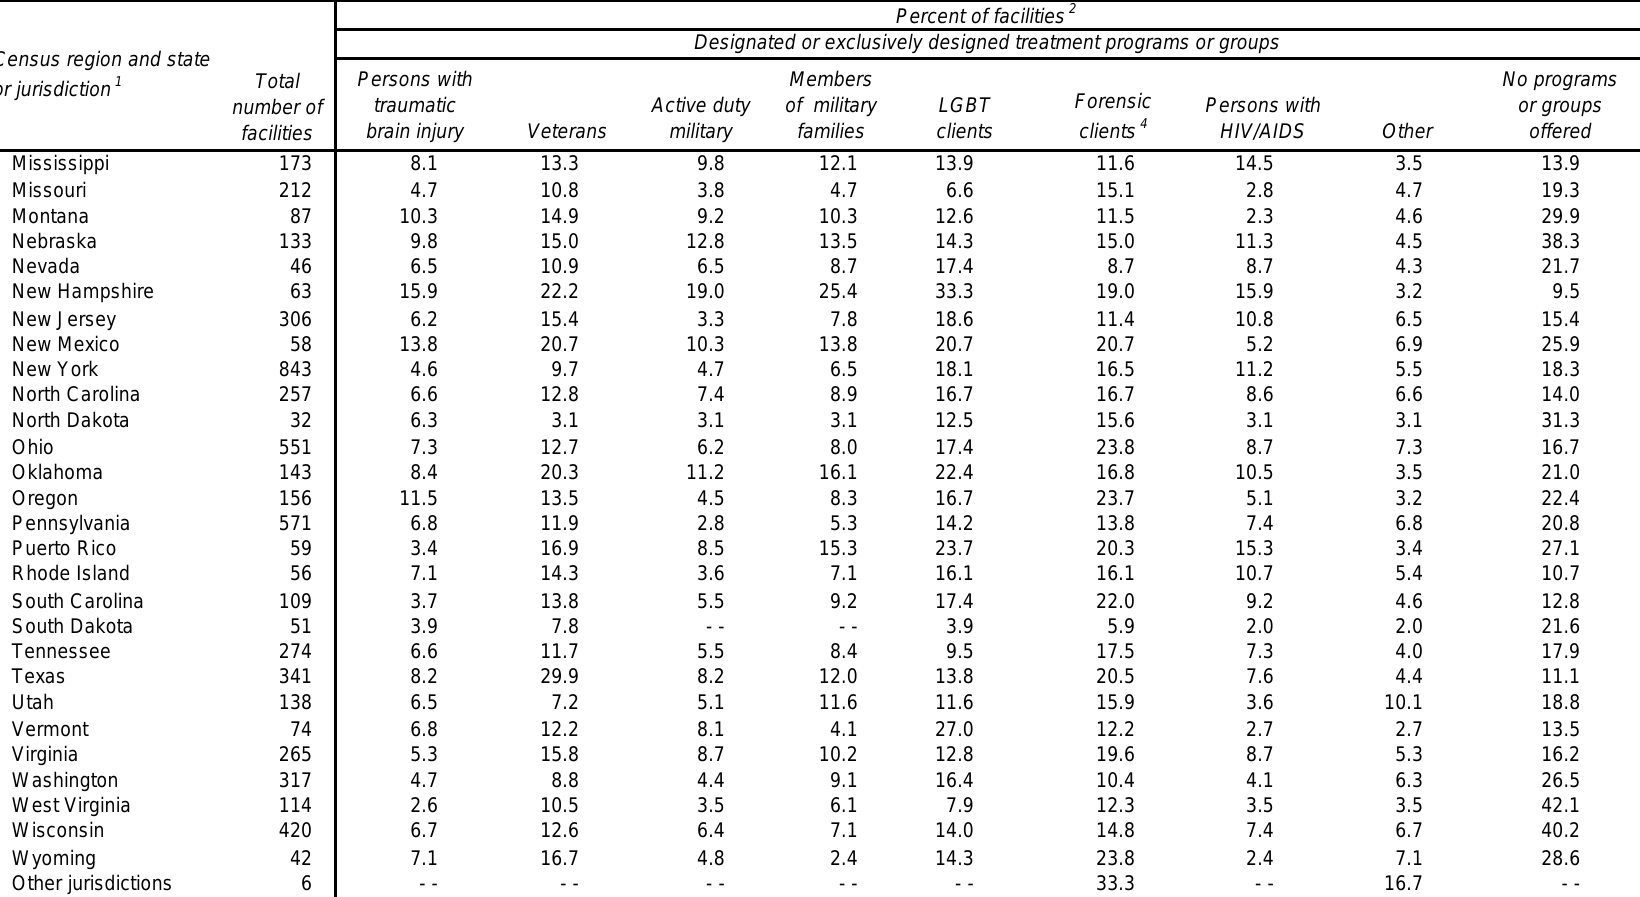
Table 3.10b. Mental health treatment facilities offering treatment programs or groups designated or designed exclusively for specific client categories,